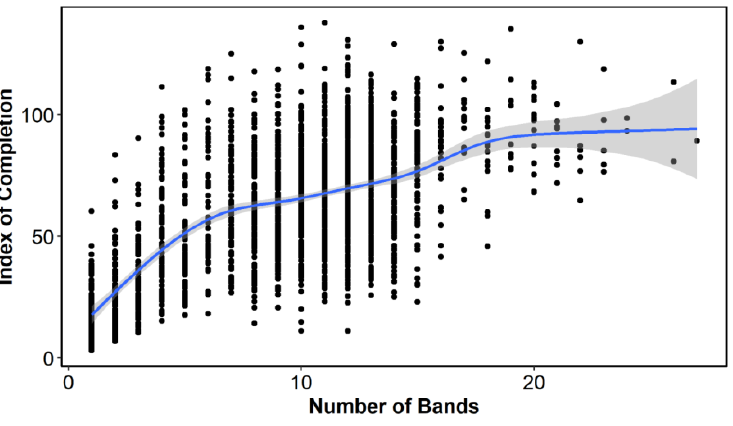
Figure 3. Index of completion by estimated age (i.e., number of opaque